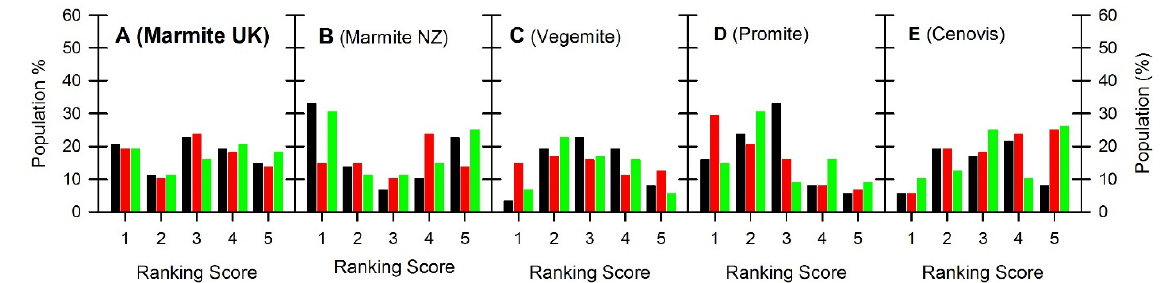
Figure 4. Ranking of yeast spreads in an impromptu sensory session in the United Kingdom ( n = 168). ( A ) ranking received by the UK Marmite (in bold); ( B ) rankings received by the New Zealand Marmite; ( C ) rankings received by Vegemite; ( D ) ranking received by Promite; and ( E ) rankings received by Cenovis. Rankings ranged from 1 to 5 as from low to high. Black bars represent the sensory perception based on sight only. Red bars represent the sensory perception based on smell only. Green bars represent the sensory perception based on taste only. Friedman ranking tests for all three attributes returned p < 0.01.